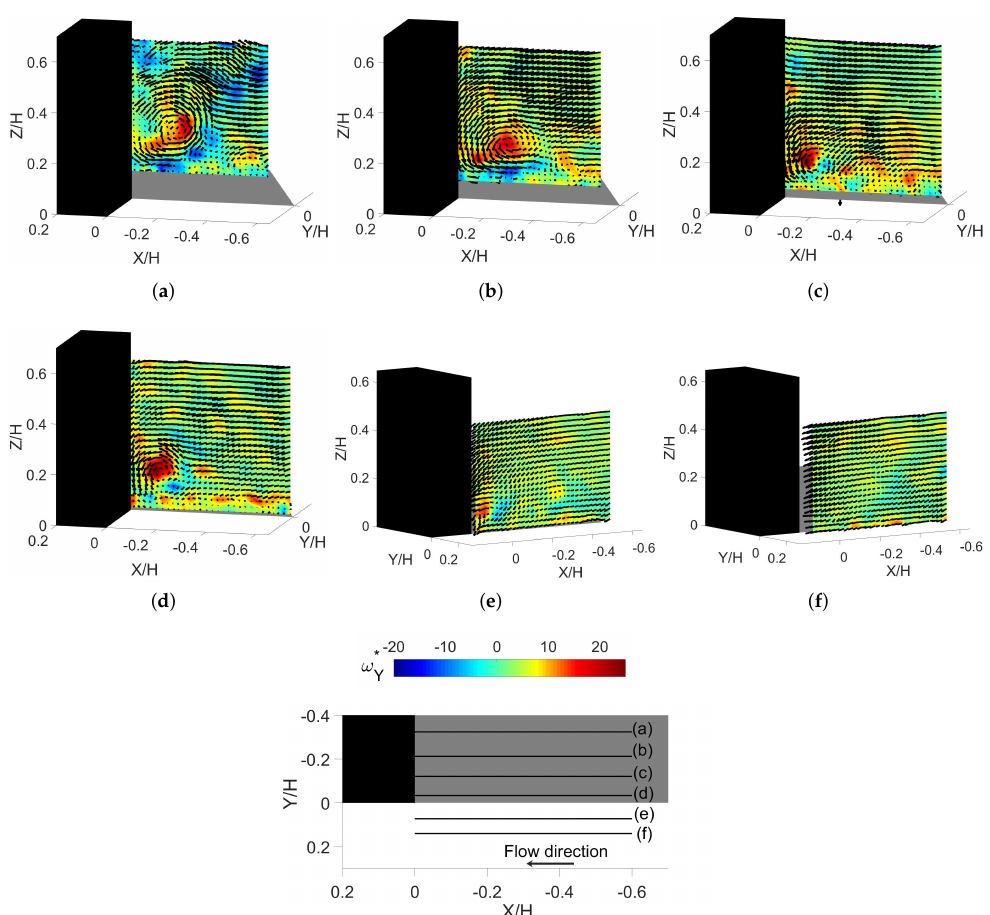
Figure 10. ( a – f ) Instantaneous dimensionless velocity vectors laied over the corresponding dimen- sionless vorticity fields (in the spanwise direction), emphasizing the position and size of JV1, from over the channel bank to within the main